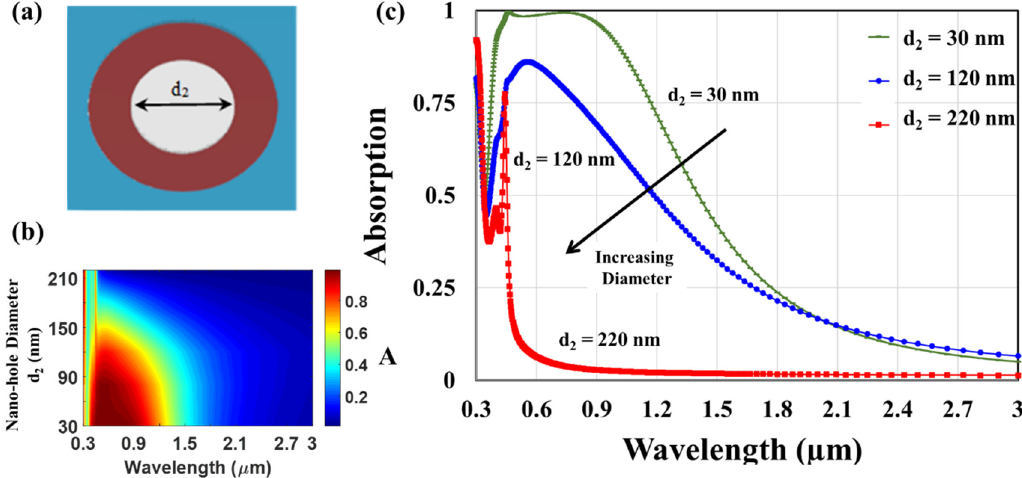
Figure 3. ( a ) Top view of nano-hole cap array and absorbance spectra ( b , c) of the proposed plasmonic absorber.